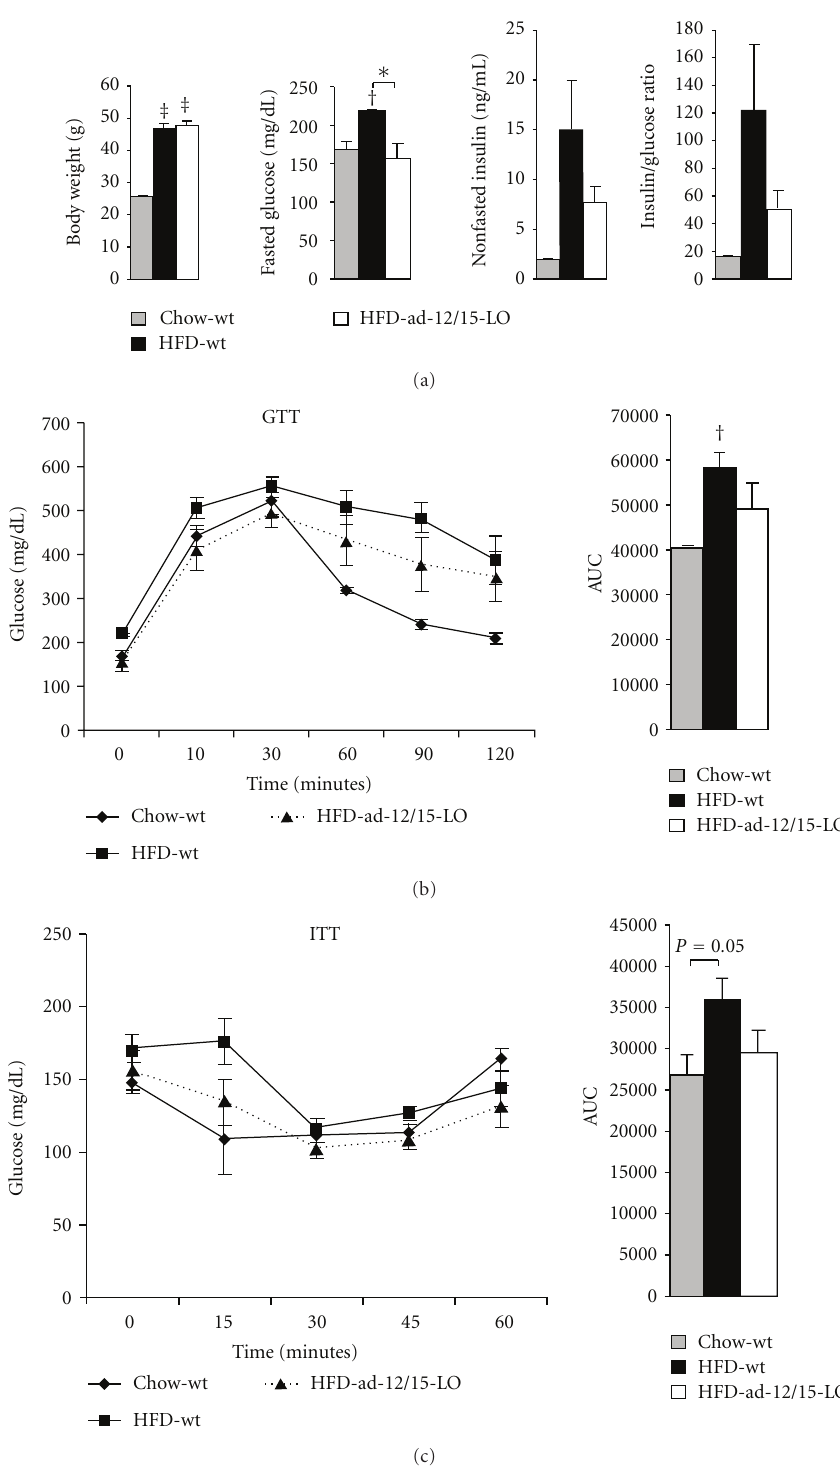
Figure 2: Fat-specific 12/15-LO-deficient mice exhibit improved glucose metabolism when fed a high-fat diet. (a) Body weight, nonfasted serum insulin, and nonfasted serum insulin/nonfasted blood glucose ratio were measured at the end of the 16-week feeding regimen. Fasted blood glucose was measured in overnight fasted mice at 15 weeks of the feeding regimen. Serum insulin levels were measured by ELISA and tail vein blood glucose by glucometers. (b)-(c) Intraperitoneal glucose tolerance test (GTT) and insulin tolerance test (ITT) were performed in mice after 15 weeks of feeding, and blood glucose measurements were measured at the indicated time points. Areas under the curves (AUC) are presented for GTT and ITT. All data represent the means ± SEM; n = 3–6. ∗ P < 0 . 05, † P < 0 . 02, ‡ P < 0 . 001 versus control, unless otherwise indicated. Chow: chow diet; HFD: high-fat diet; wt: wild type 12/15 - LO loxP/loxP